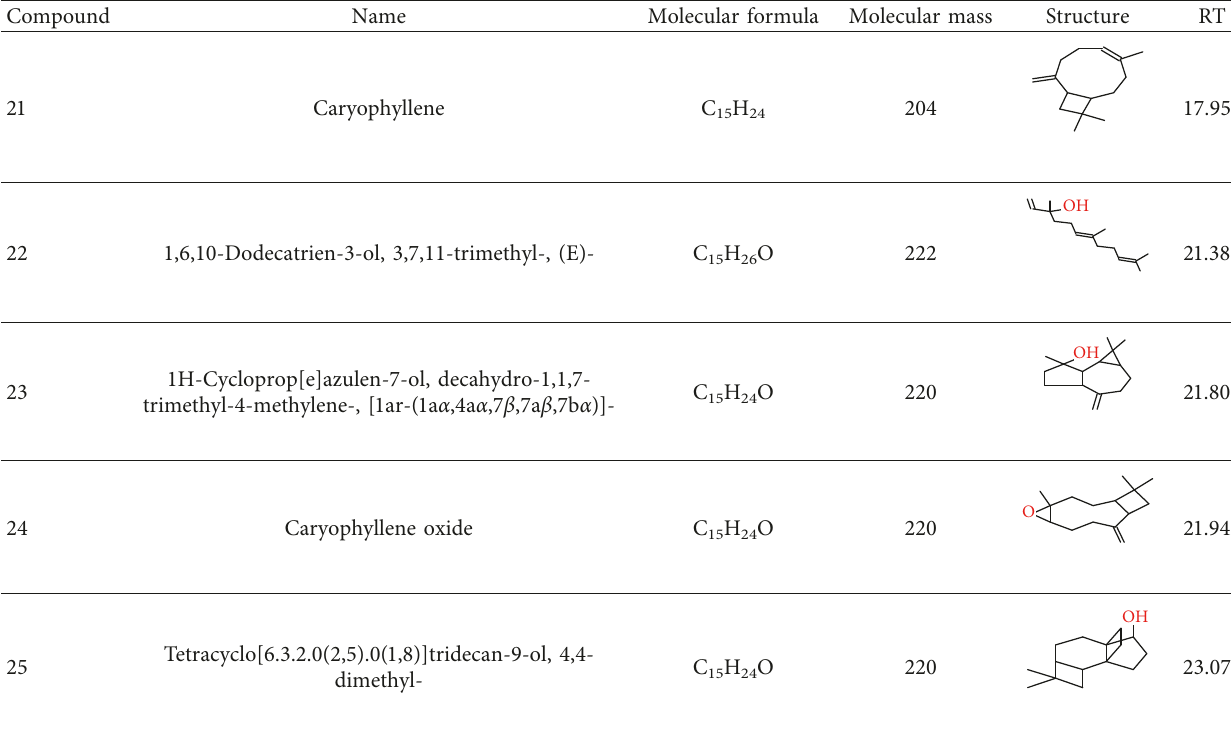
Table 6: Molecular formula, molecular mass, structure, and RTof compounds 21–25 of whole plant n -hexane fraction of Achillea wilhelmsii (WHFAW).